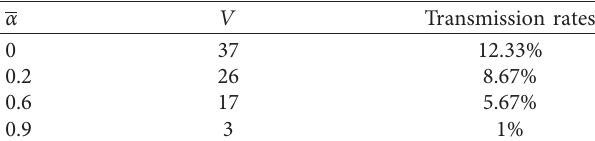
Table 1: Transmission rates. Table 2: Different modes of M